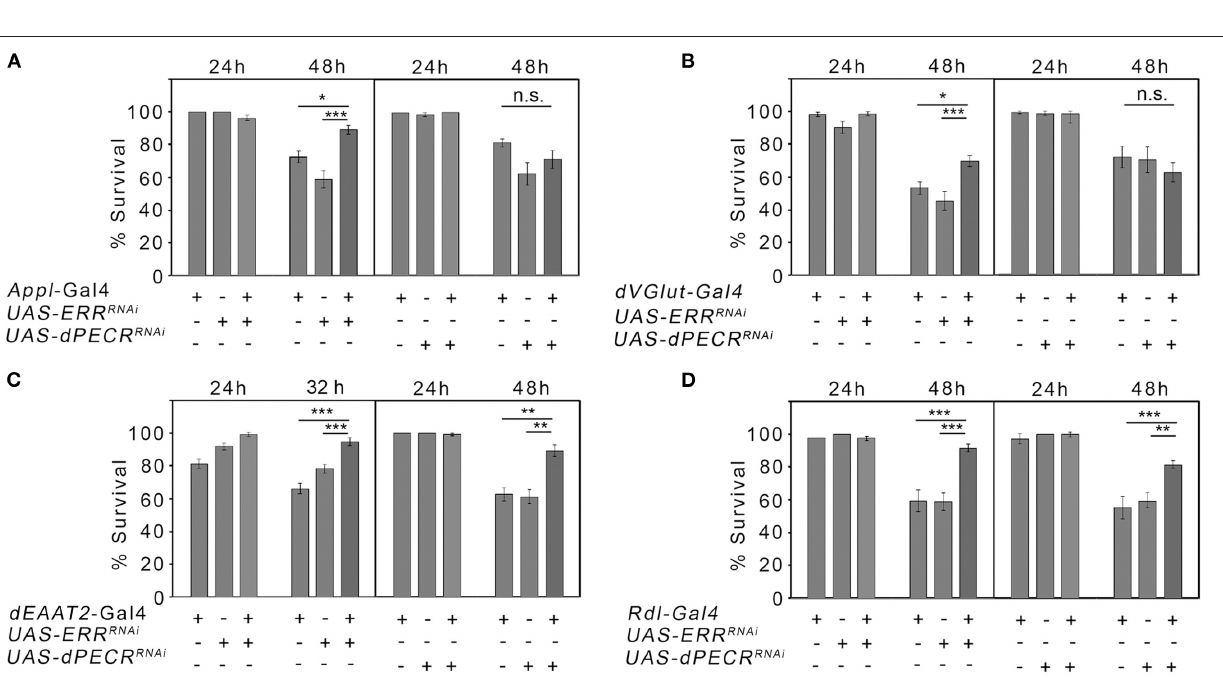
FIGURE 2 | dPECR KG 07864 : 0.17 ± 0.04; twins CB 5218 − 3 : 0.11 ± 0.02; Gpdh1 CB 6367 − 3 : 0.42 ± 0.11; for transheterozygous flies carrying a Ku80 RNAi transgene under